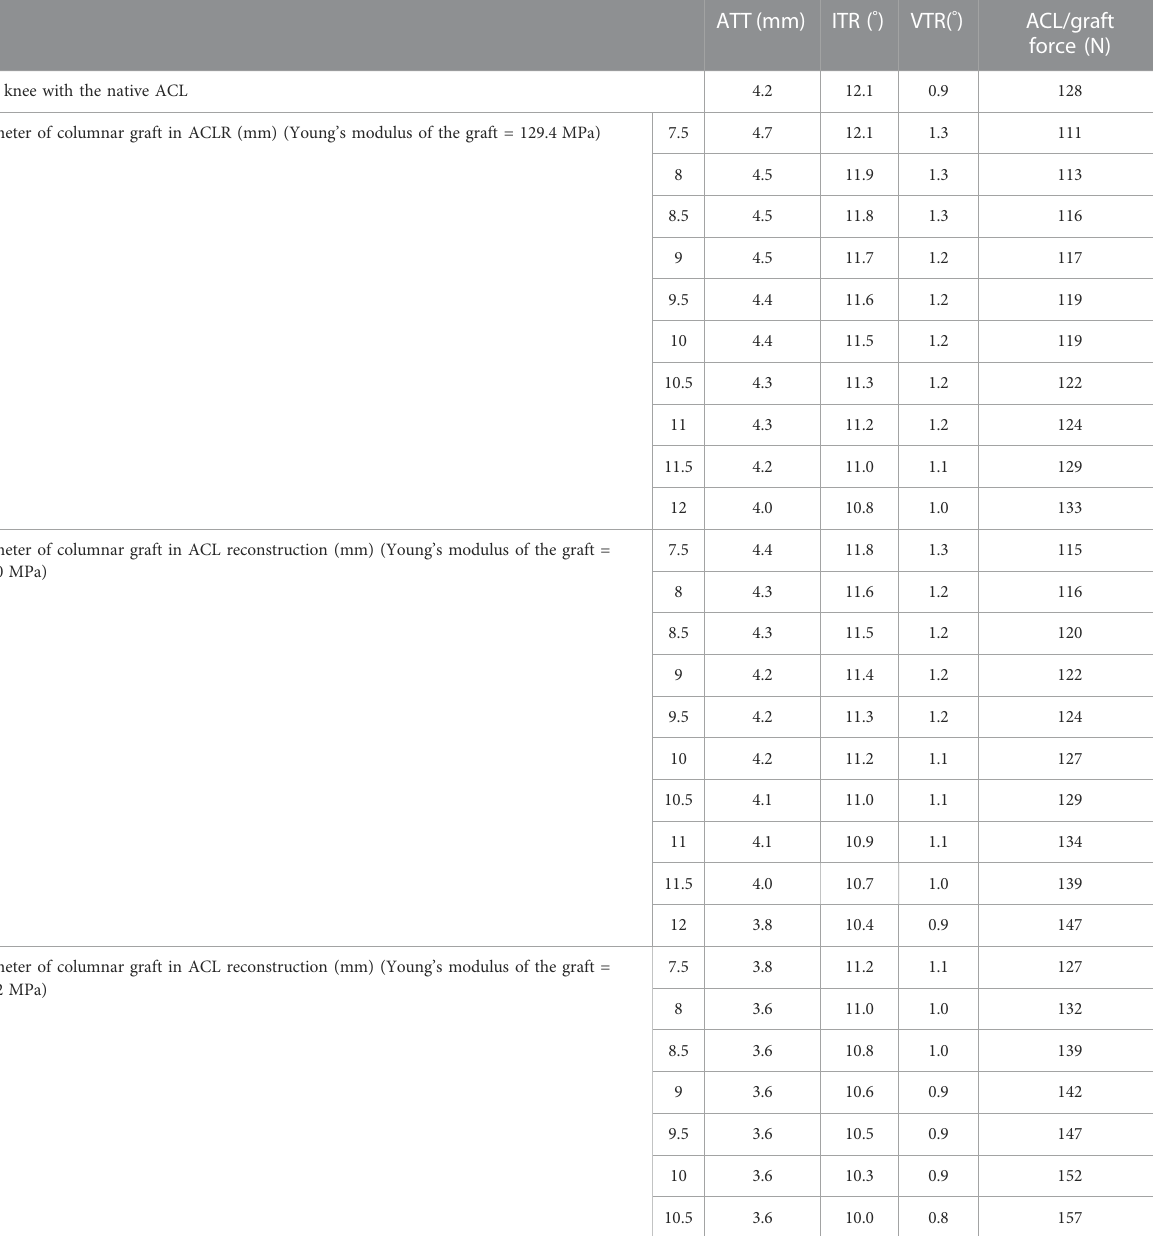
TABLE 2 ATT, Anterior tibial translation; IRT, internal tibial rotation; VTR, valgus tibial rotation and ACL/graft force in the intact knee and knee after ACLR using columnar grafts with different elasticity.